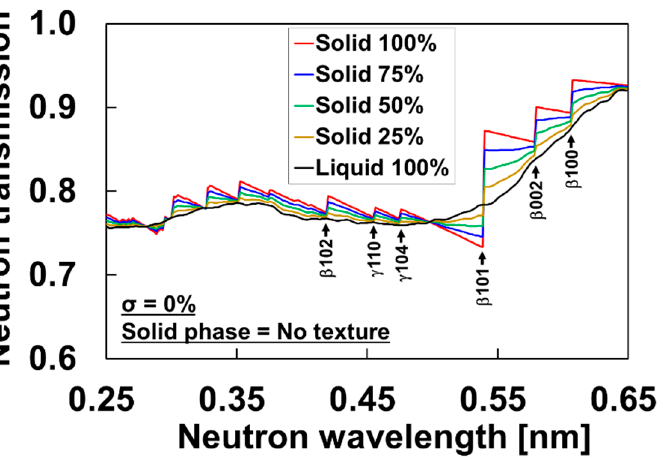
Figure 1. Neutron transmission spectra (Gaussian error σ = 0%) of lead-bismuth eutectic alloy (LBE) simulating the solid–liquid mixed state when the solid phase had an isotropic texture (March–Dollase coefficient (MD) = 1.0).